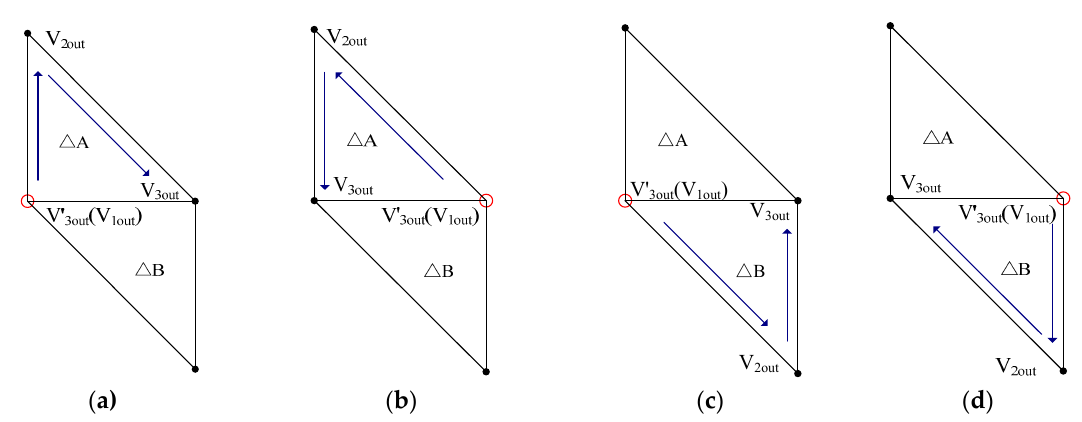
Figure 7. Switching paths in the second kind of quadrangle, ( a ) state 1; ( b ) state 2; ( c ) state 3; ( d ) state 4.